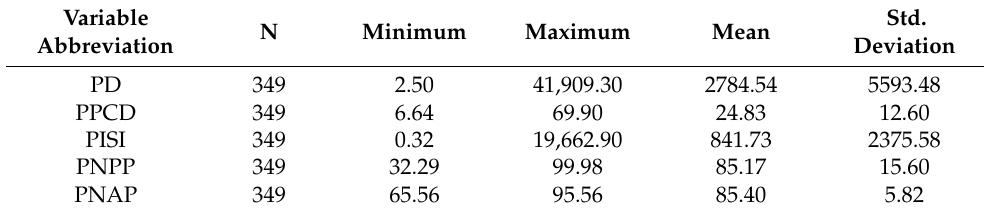
Table 9. Descriptive statistics for each